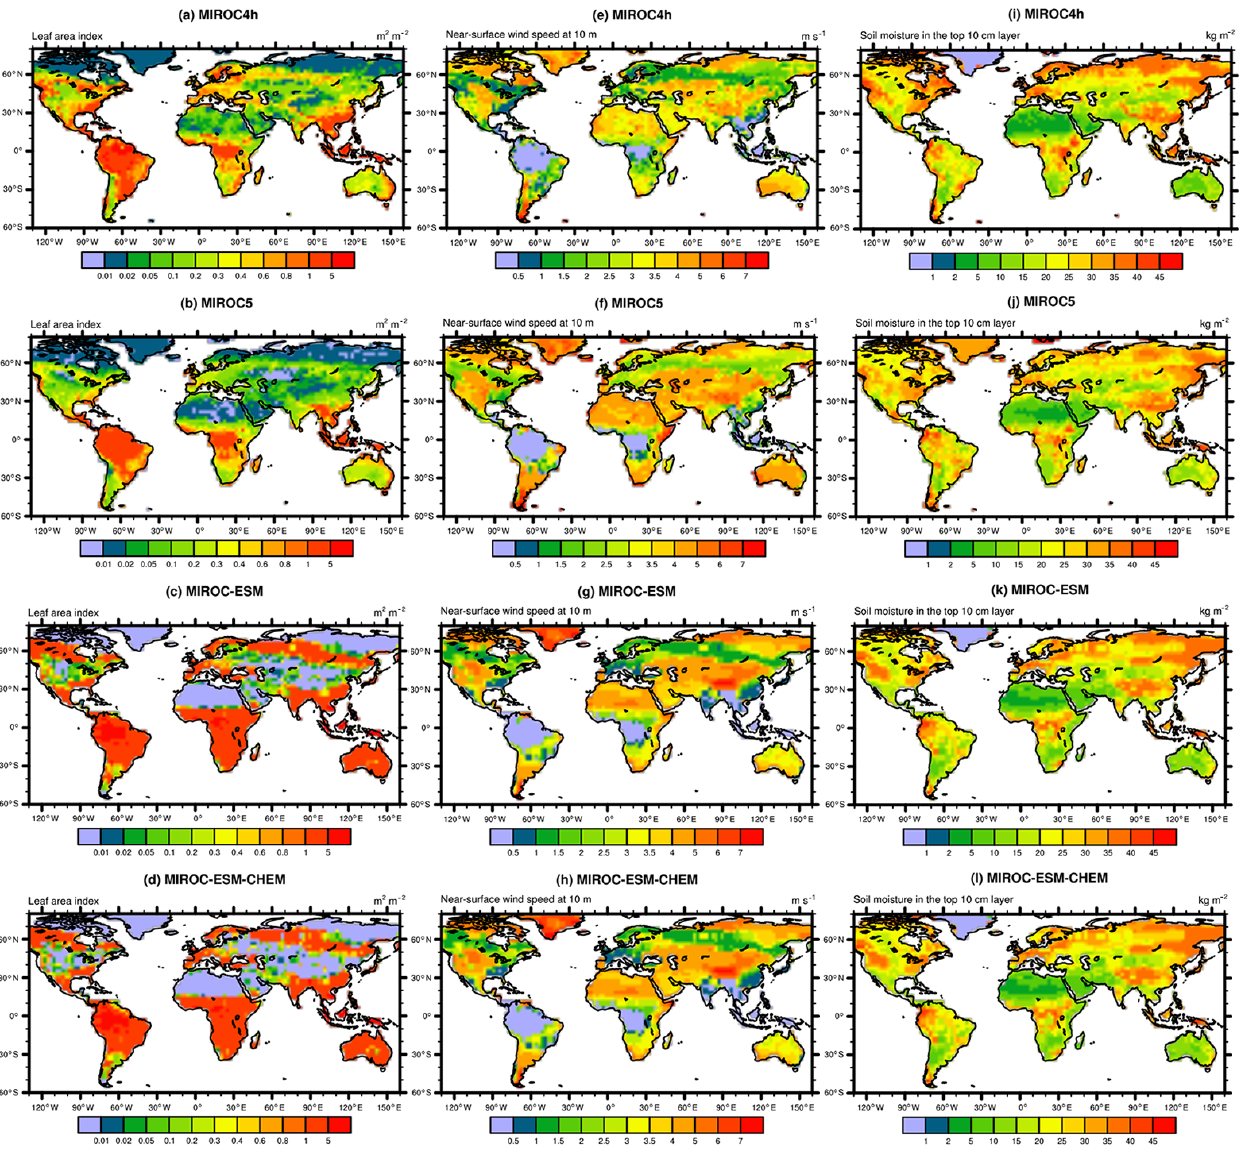
Figure 5. Minimum leaf area index of a calendar year (m 2 m − 2 ), annual mean surface wind speed at 10m (ms − 1 ), and mean soil moisture in the top 10cm layer (kgm − 2 ) during 1960–2005 in four MIROC family models. For each grid box, the monthly mean leaf area index for each month of a calendar year is first derived based on the average of 1960–2005, and then the minimum of the leaf area index among these months (i.e. January to December) is